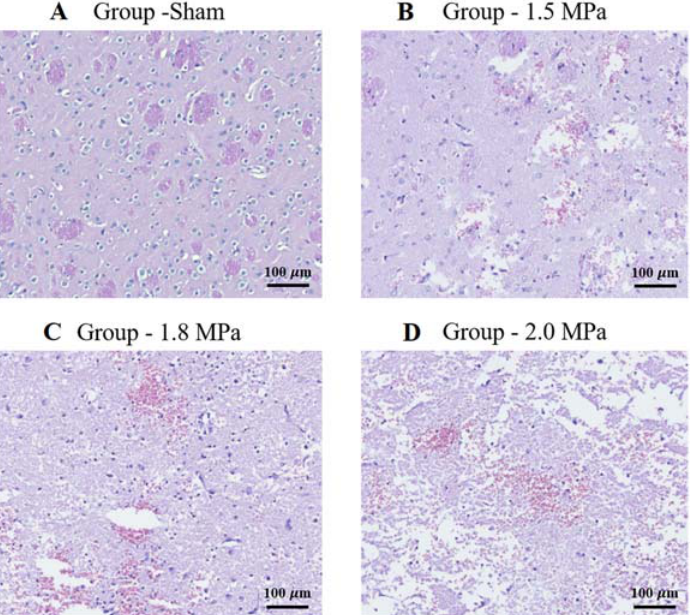
Figure 5. H&E staining: representative brain sections of sham and sonication. Histopathological findings in the petechial hemorrhage model using focused ultrasound in rats. As the intensity of ultrasound increases, the brain tissue shows an increased amount of gliosis, extravasated red blood cells, congestion, and destruction of small blood vessels, which is consistent with petechial hemorrhage. ( A ) Sonication intensity group sham. ( B ) Sonication intensity group 1.5 Mpa. ( C ) Sonication intensity group 1.8 Mpa. ( D ) Sonication intensity group 2.0 Mpa. Original magnification: ( A – D ), (150× magnification). Scalebar = 100 μ m.